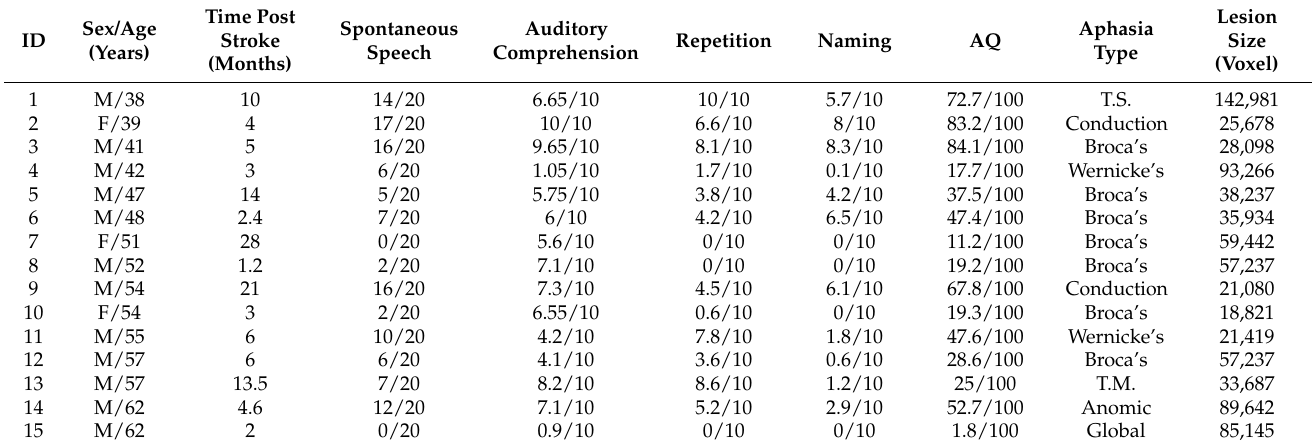
Table 2. The Western Aphasia Battery test scores for patients with aphasia.